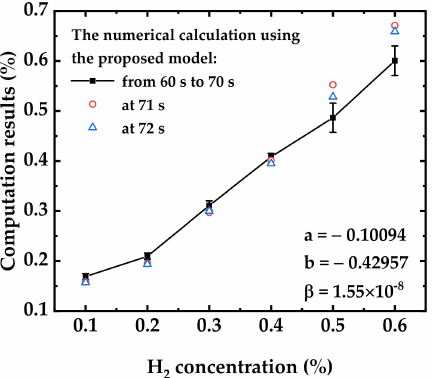
Figure 6. Fitting and calculation of hydrogen dynamic sensing under dry conditions. The black squares represent the fitting results obtained using the data in Figure 2a from 60 s to 70s. The red hollow circles and blue hollow triangles represent the concentration values calculated by substitute the current values from Figure 2a at 71 s and 72 s into the model (Equations (22) and (23)),